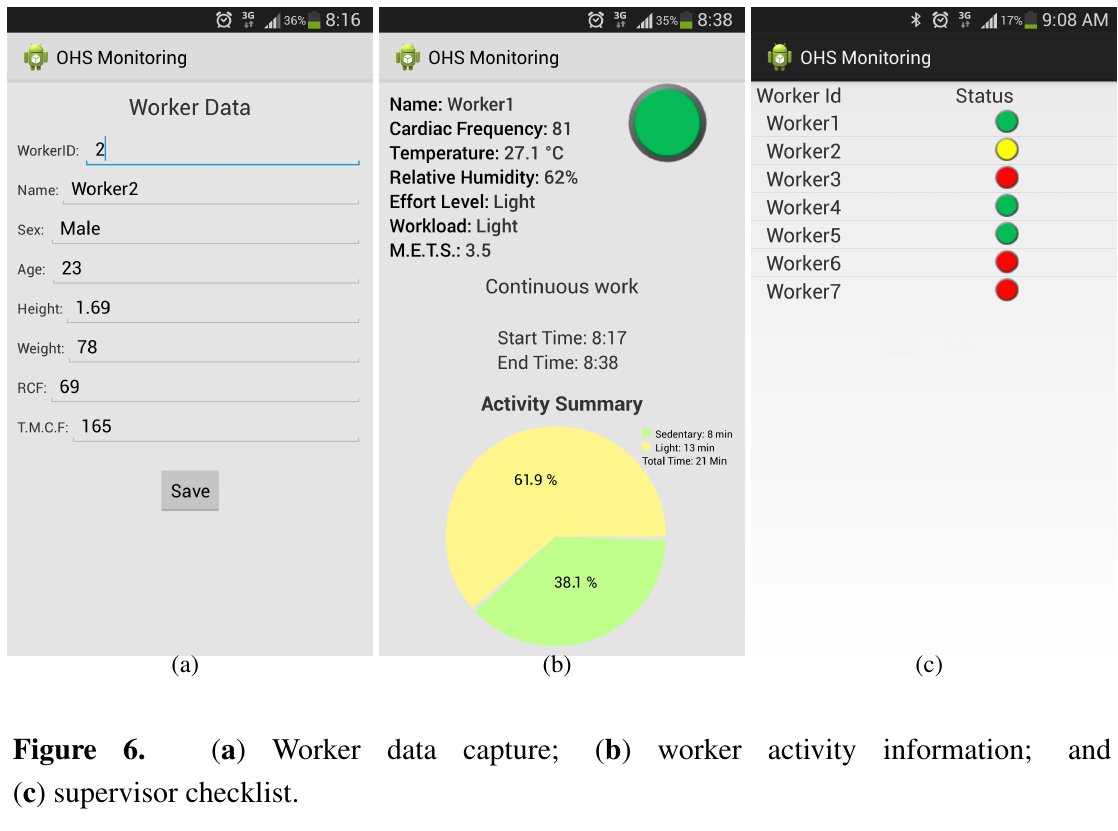
Figure 6. ( a ) Worker data capture; ( b ) worker activity information; and ( c ) supervisor